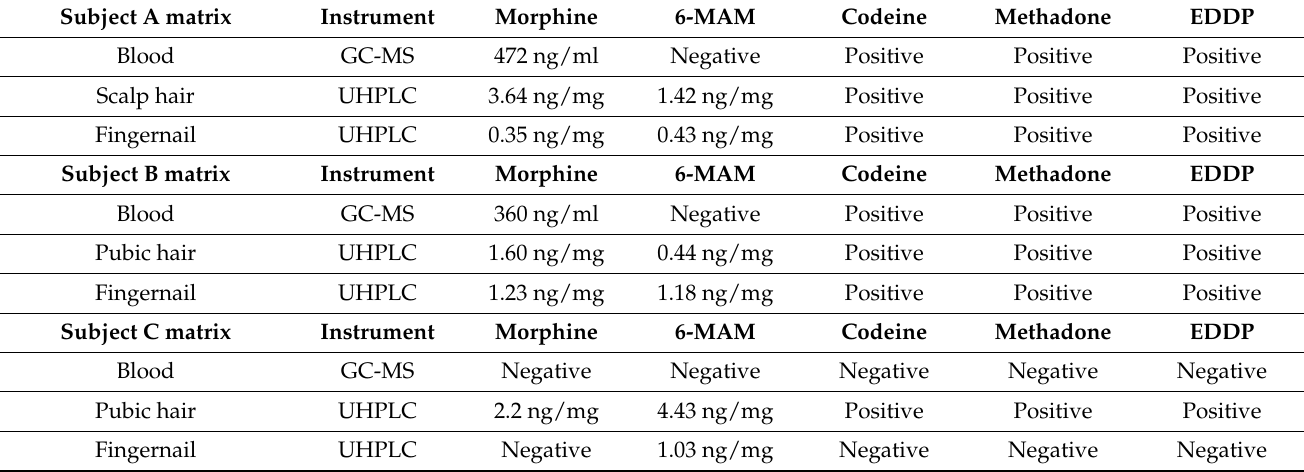
Table 4. UHPLC and GC-MS analysis results for morphine and opioids